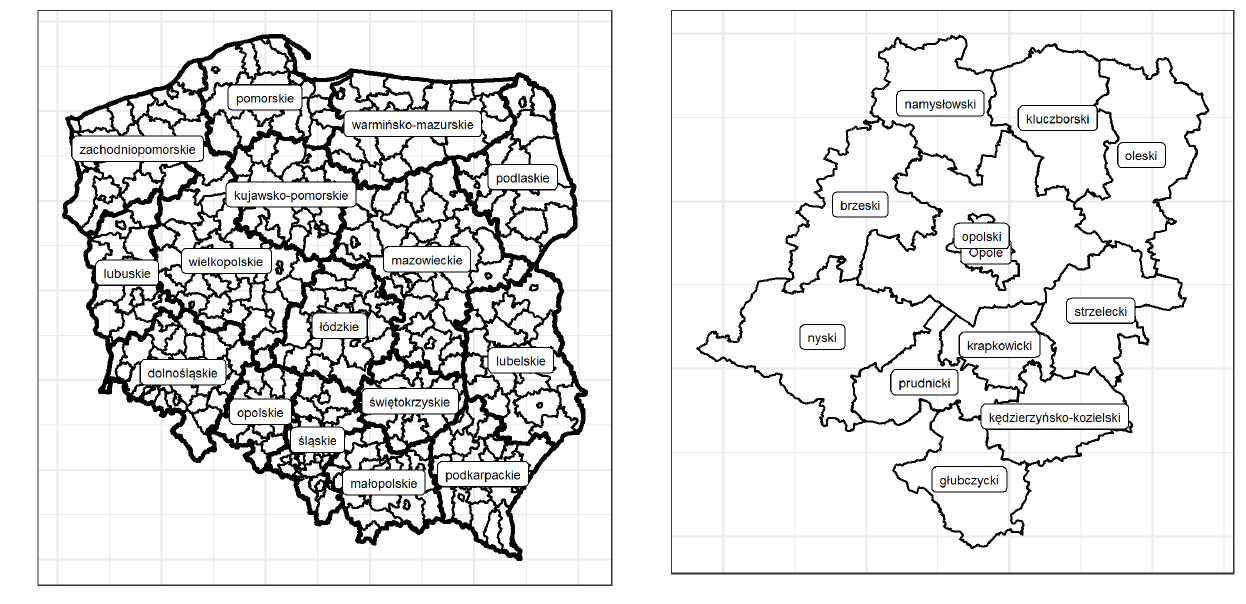
Figure 1. Administrative division of Poland—provinces and